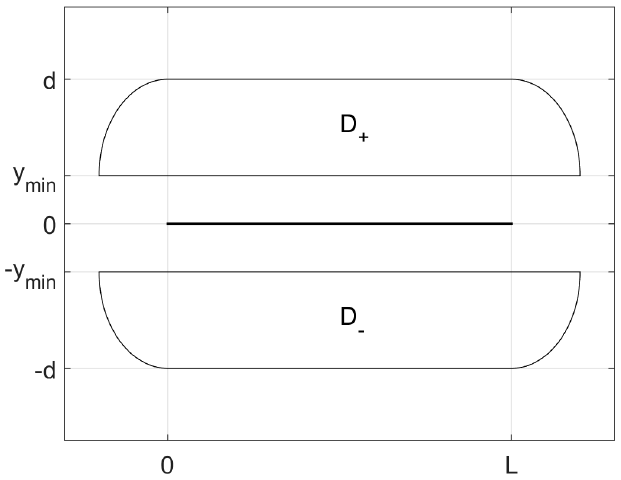
Figure 5. Graphical representation of the domain D defined in Equations (15)–(17).